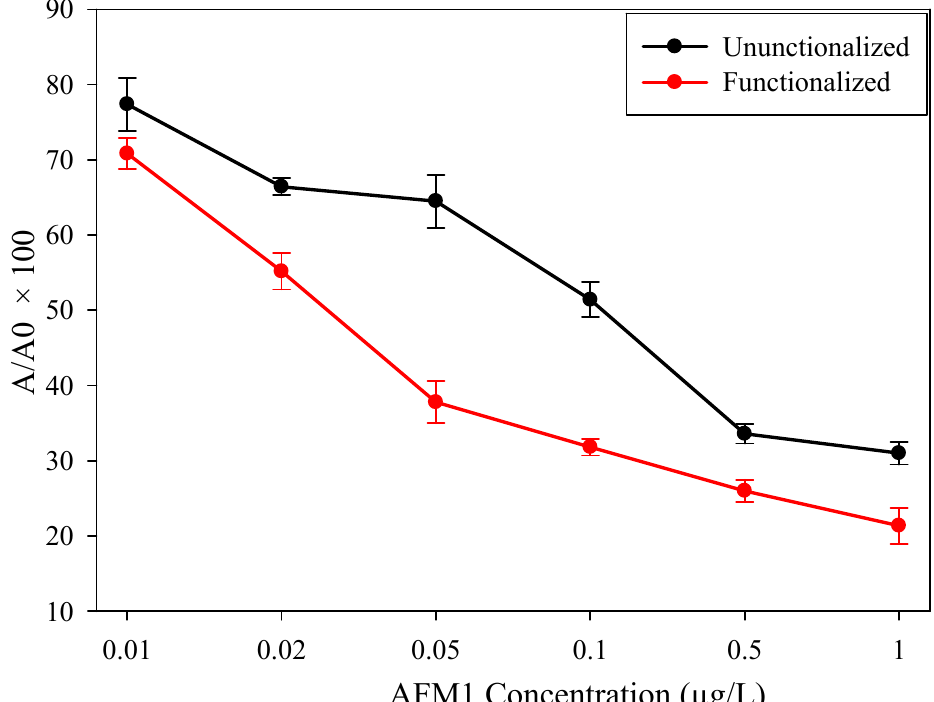
Figure 6. Chronoamperometric measurement of AFM1 in spiked milk sample; A 0 is the sensor response without AFM1.